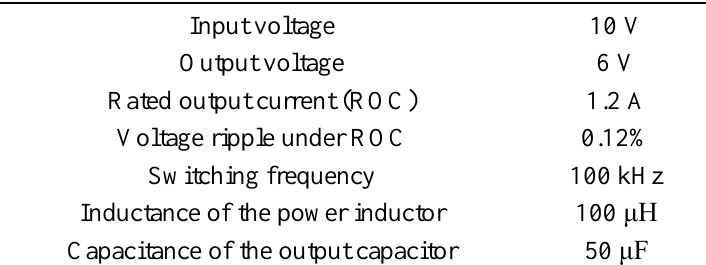
Table 1. Design specifications of the buck converter.